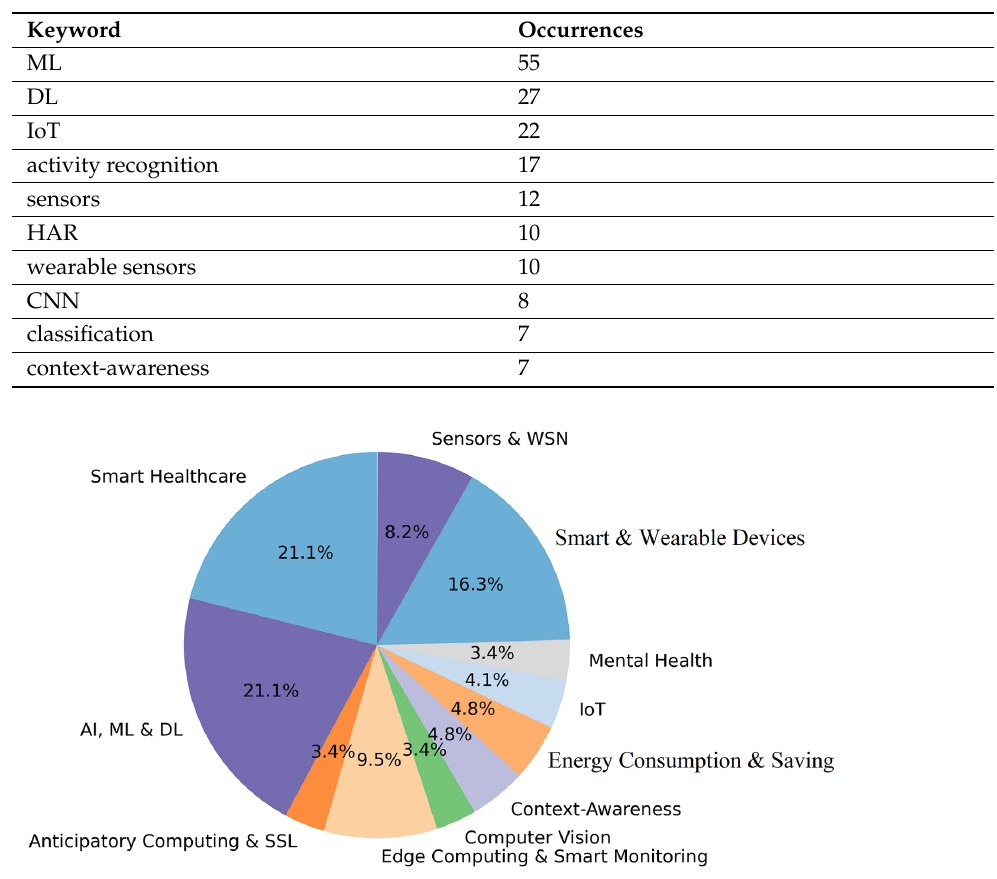
Figure 9. Percentage of papers of sample studied per the main identified subjects. The most repre- sented subjects are AI, ML and DL and Smart Healthcare followed by Smart and Wearable Devices, Edge Computing and Smart Monitoring and Sensors and WSN. These well reflect the survey